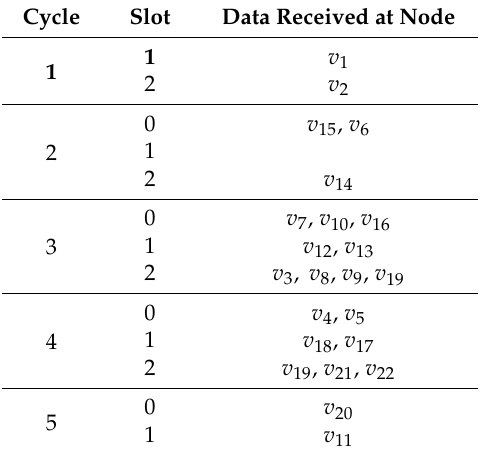
Table 5. Data packet dissemination using ABRCD.